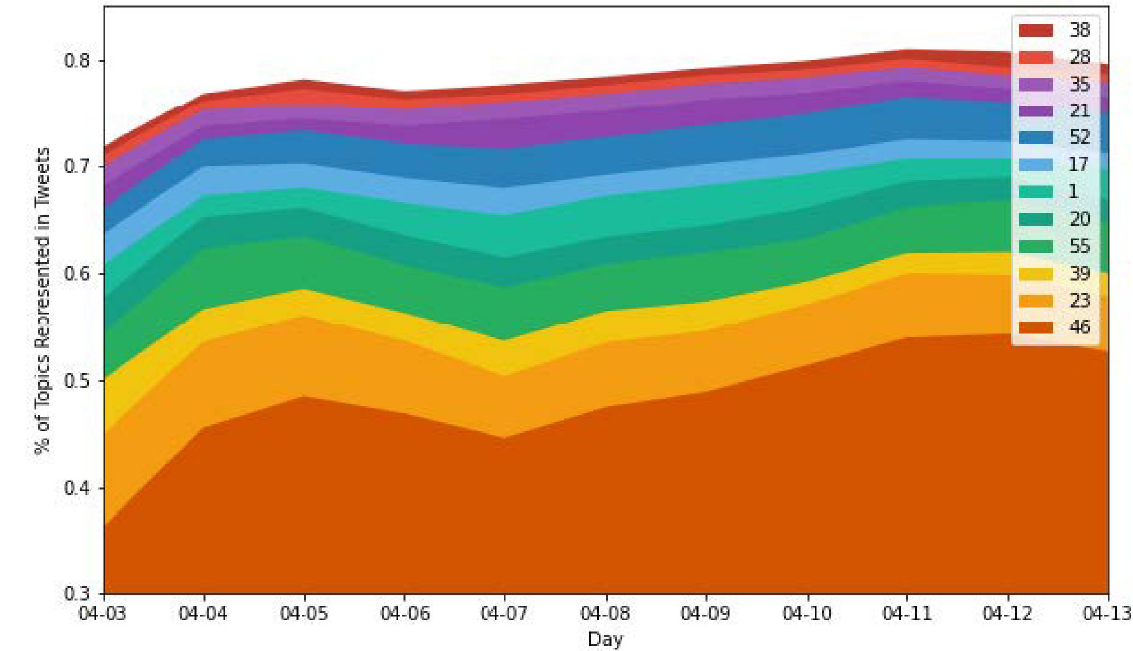
Fig 6. Time-series representation of the changes in topic dominance over